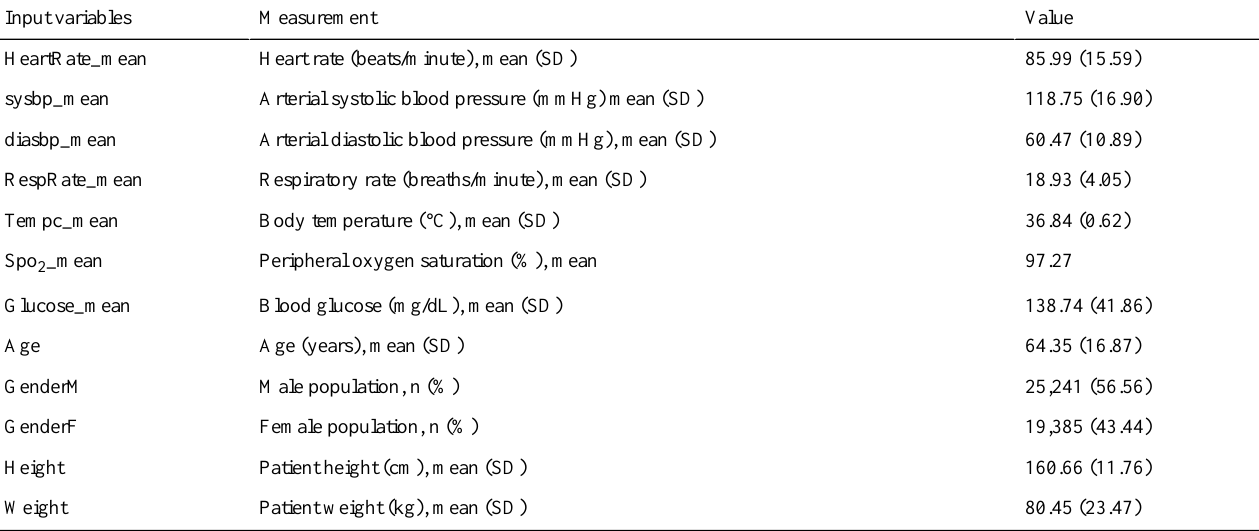
Table 2. Descriptive statistics for baseline model predictors (N=44,626).